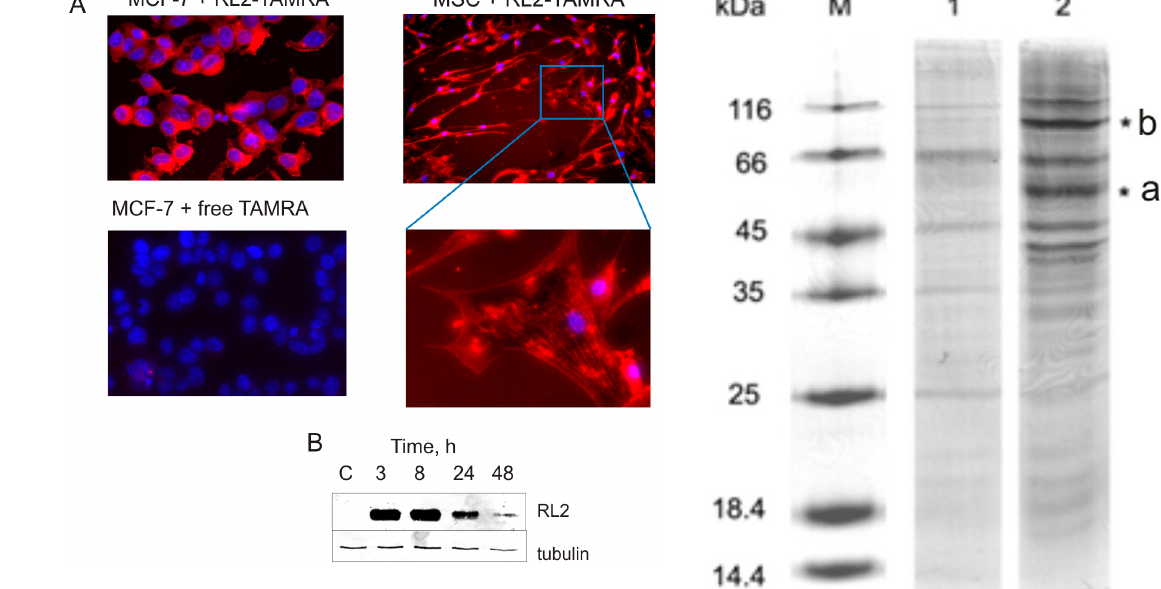
Figure 3. RL2 penetrates into the cells. A . Fluorescence microscopy analysis of MCF-7 and MSC cells was performed after treatment with RL2-TAMRA conjugate for 1.5 h using the IN CELL Analyzer system. For visualization of nuclei the cells were stained with DAPI. Images are representative of two independent experiments. B . Time-course of RL2 stability in MCF-7 cells. Cells were treated with RL2 (0.2 mg/mL) for the indicated time followed by the preparation of whole-cell lysates, which were then subjected to Western blot with anti- RL2 antibodies. Results shown are representative of five independent experiments.